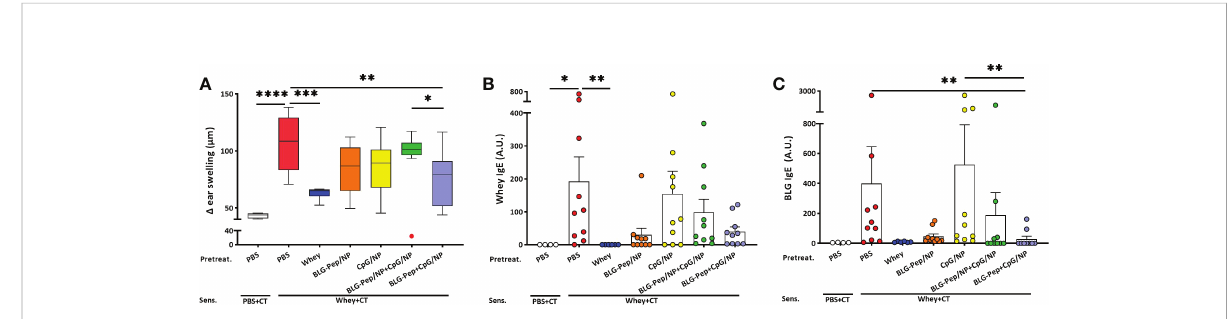
FIGURE 2 Acute allergic skin response and BLG- and whey-speci fi c serum immunoglobulin E. Five days after last sensitization, mice were intradermally challenged in the ear pinnae with 10 µg whey followed by oral challenge. The acute allergic skin response was measured 60 min afterwards in the in vivo study (A) . BLG- (B) and whey-speci fi c (C) IgE levels are measured in serum, which were collected 18 h after last oral challenge with whey in mice from all groups of the animal study. Data are presented as box-and-whisker Tukey plots for (A) , and mean ± SEM for (B, C)